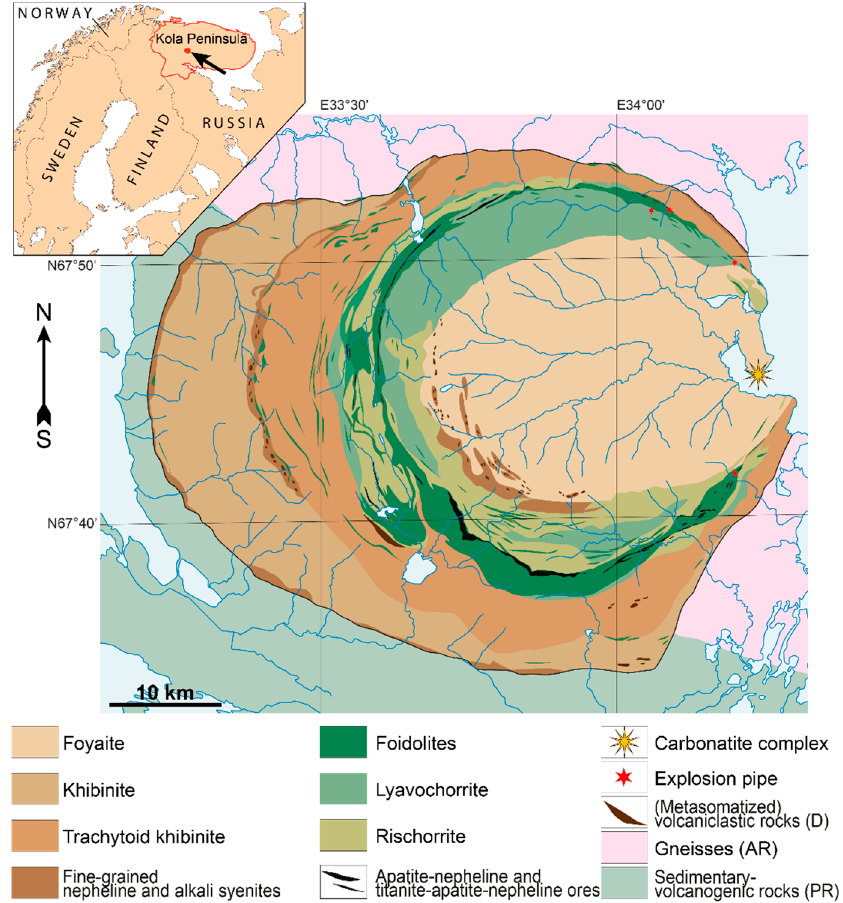
Figure 1. Geological scheme of the Khibiny massif [43].